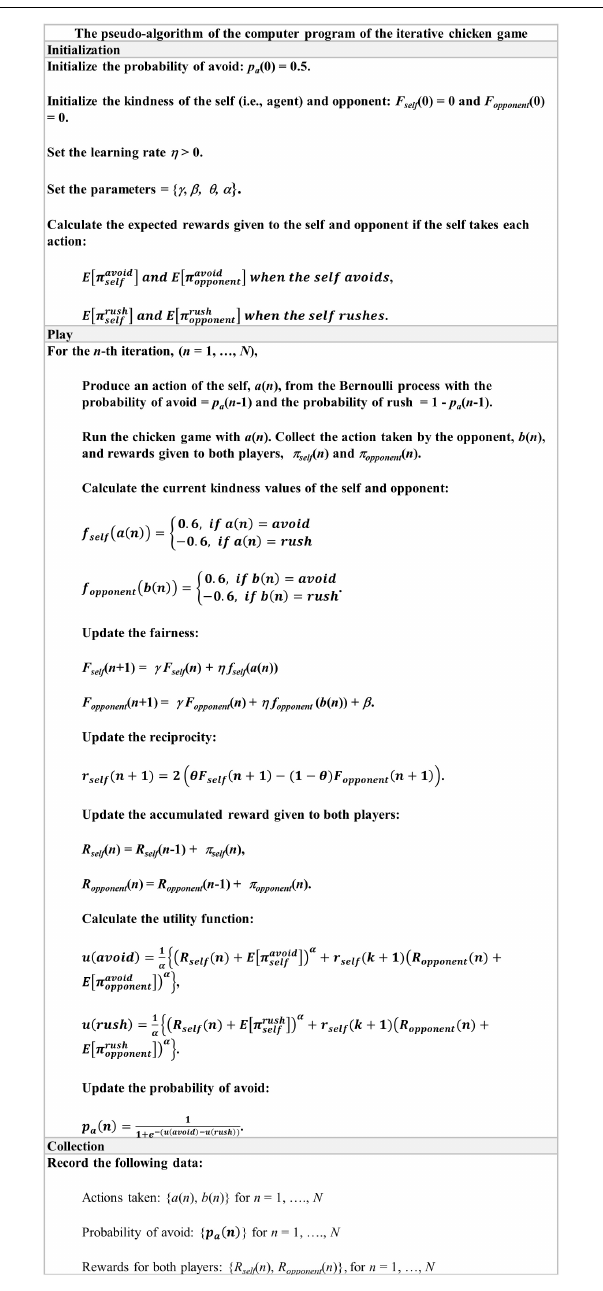
the horizontal lane along with the text showing a ready